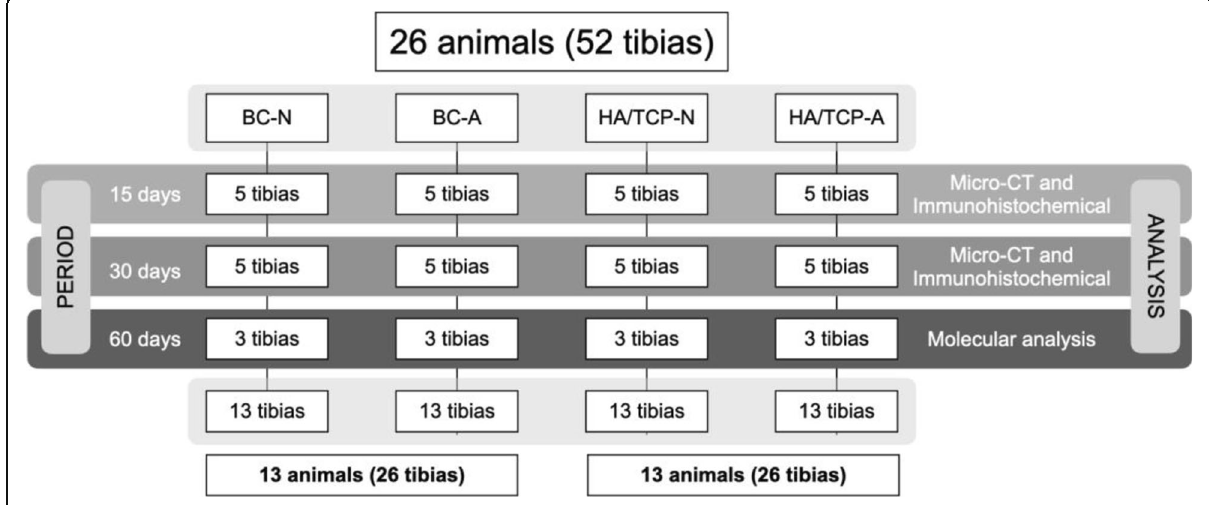
Fig. 1 Materials and methods scheme (flowchart)